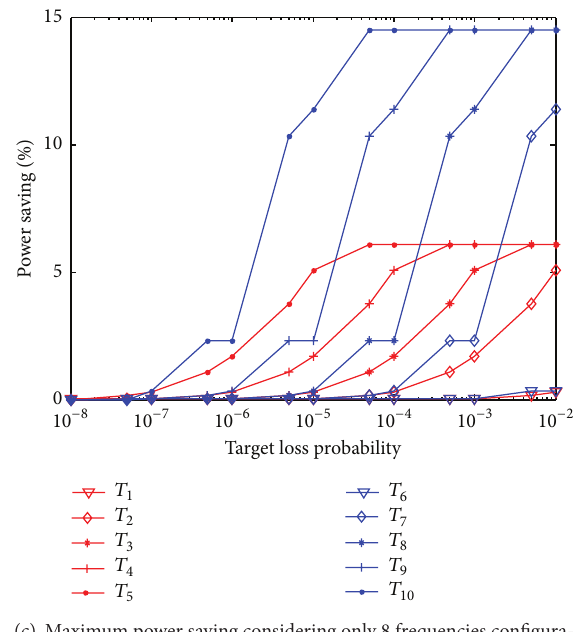
Figure 6: Power saving versus target loss probability resulted by optimization problem fixing the number of